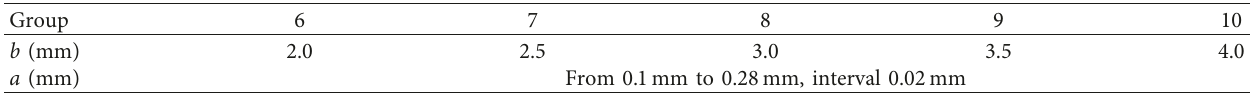
Table 2: Particle size for theoretical calculation.